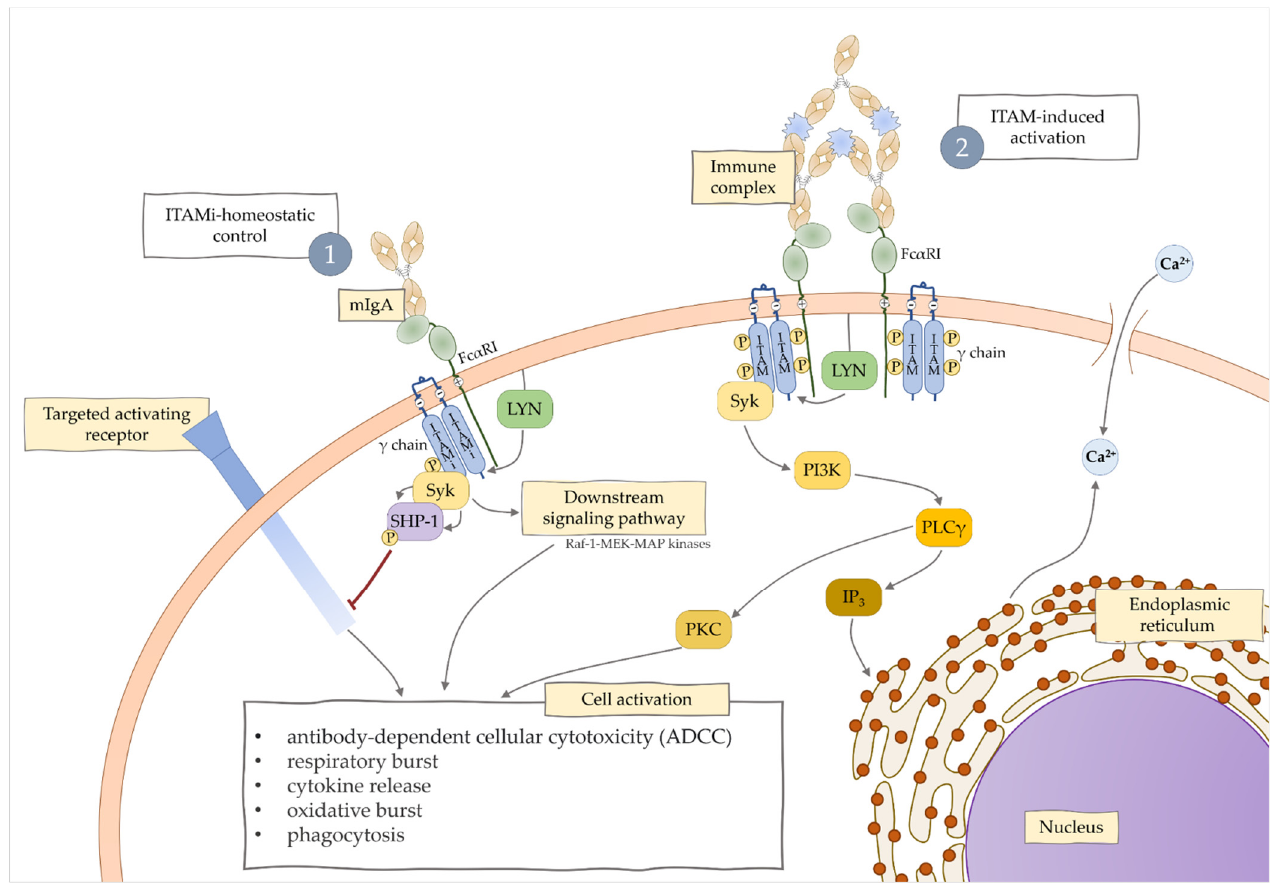
Figure 1. Regulation of immune responses by Fc α RI, including ITAM-induced activation and ITAMi-control.